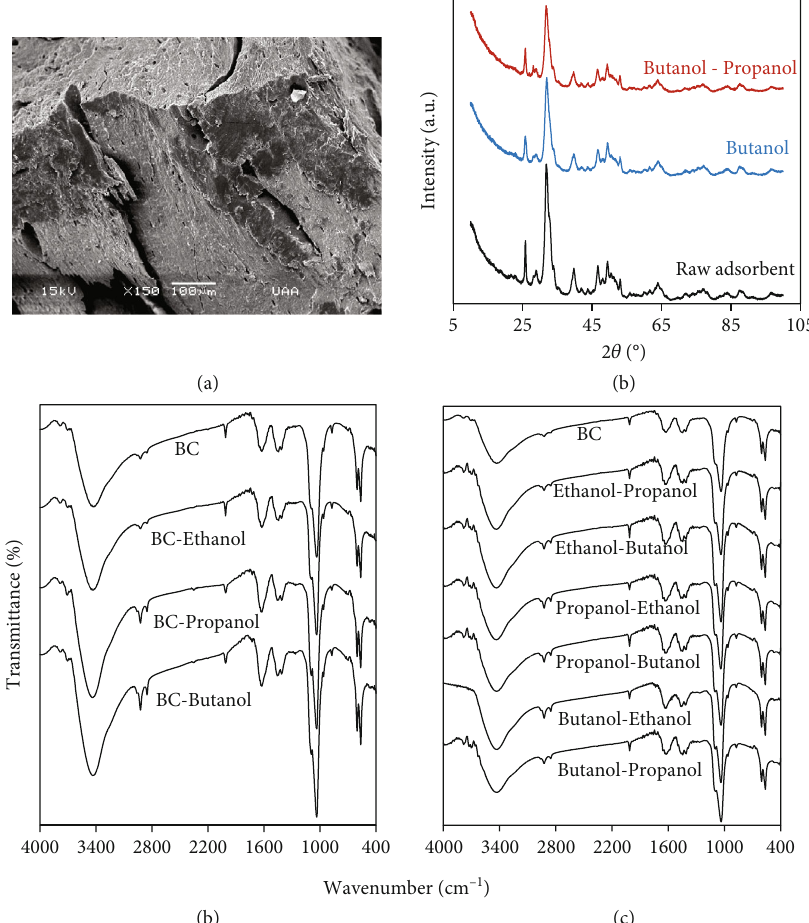
Figure 5: (a) SEM image, (b) X-ray di ff raction, and (c) FTIR spectra of bone char used for the recovery of bioalcohols from aqueous